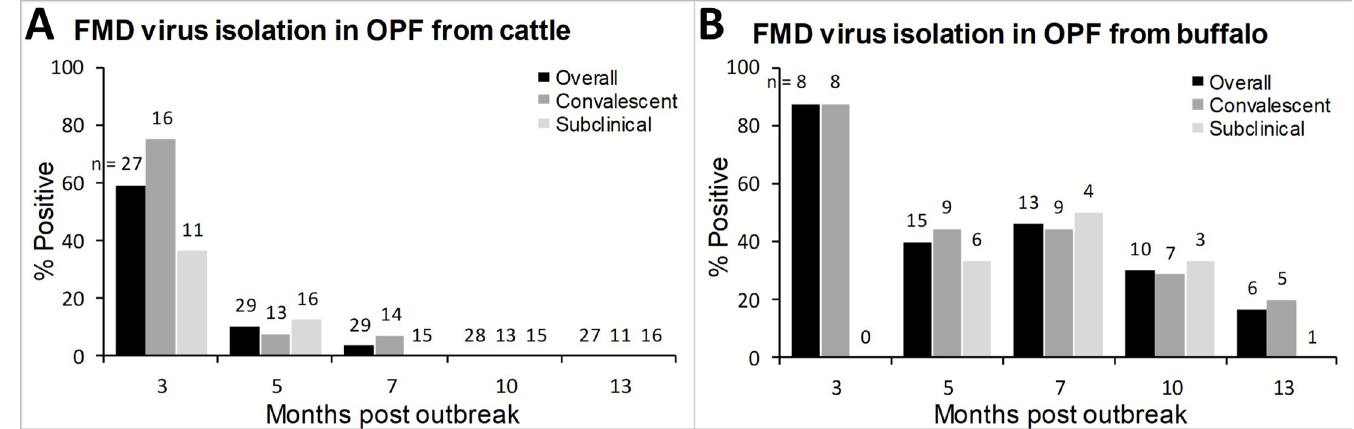
Fig 2. Proportion of convalescent, subclinical, and overall proportion of carrier cattle (A) and buffalo (B) from which infectious FMDV was isolated from OPF. Numbers indicate the total number of animals sampled at each sampling period.